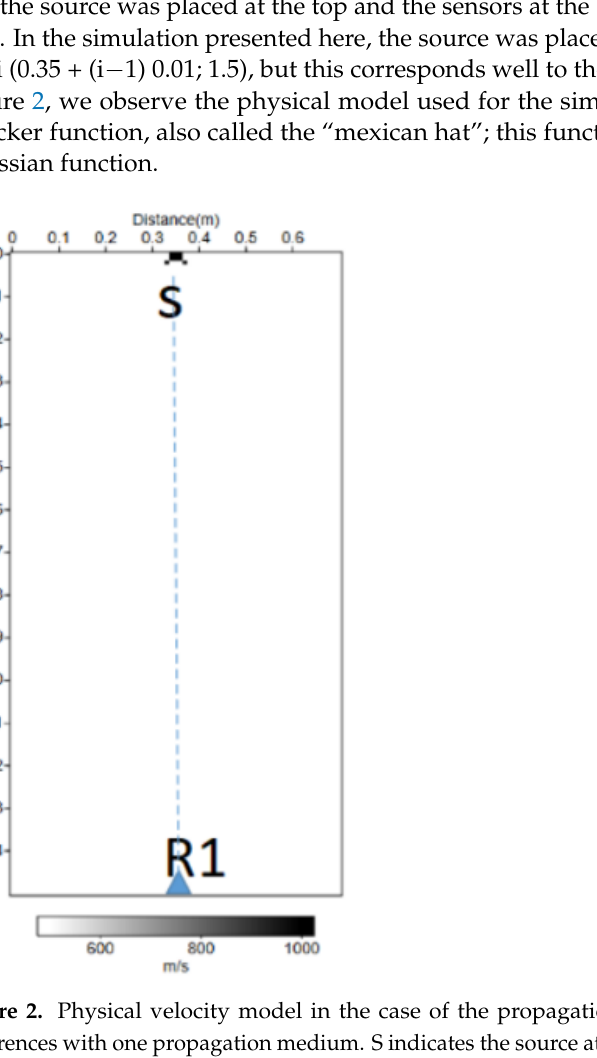
is the first receiver. 1